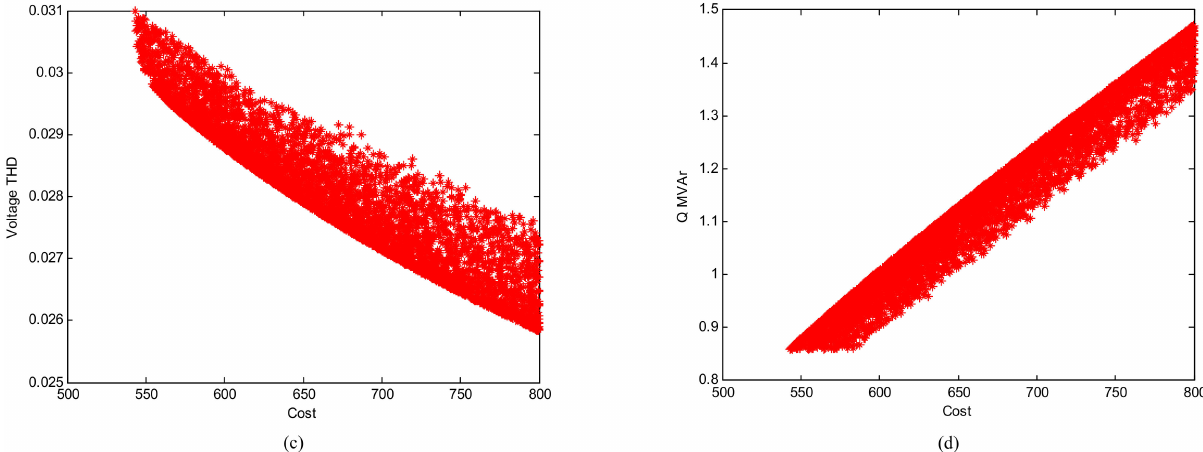
Figure 10. Pareto front set obtained by Monte Carlo simulations: ( a ) voltage THD vs. current THD; ( b ) current THD vs. cost, ( c ) voltage THD vs. cost, ( d ) reactive power compensation vs. cost. Table 9. Generational distance—MOTLBO with MOBA and MOPSO.